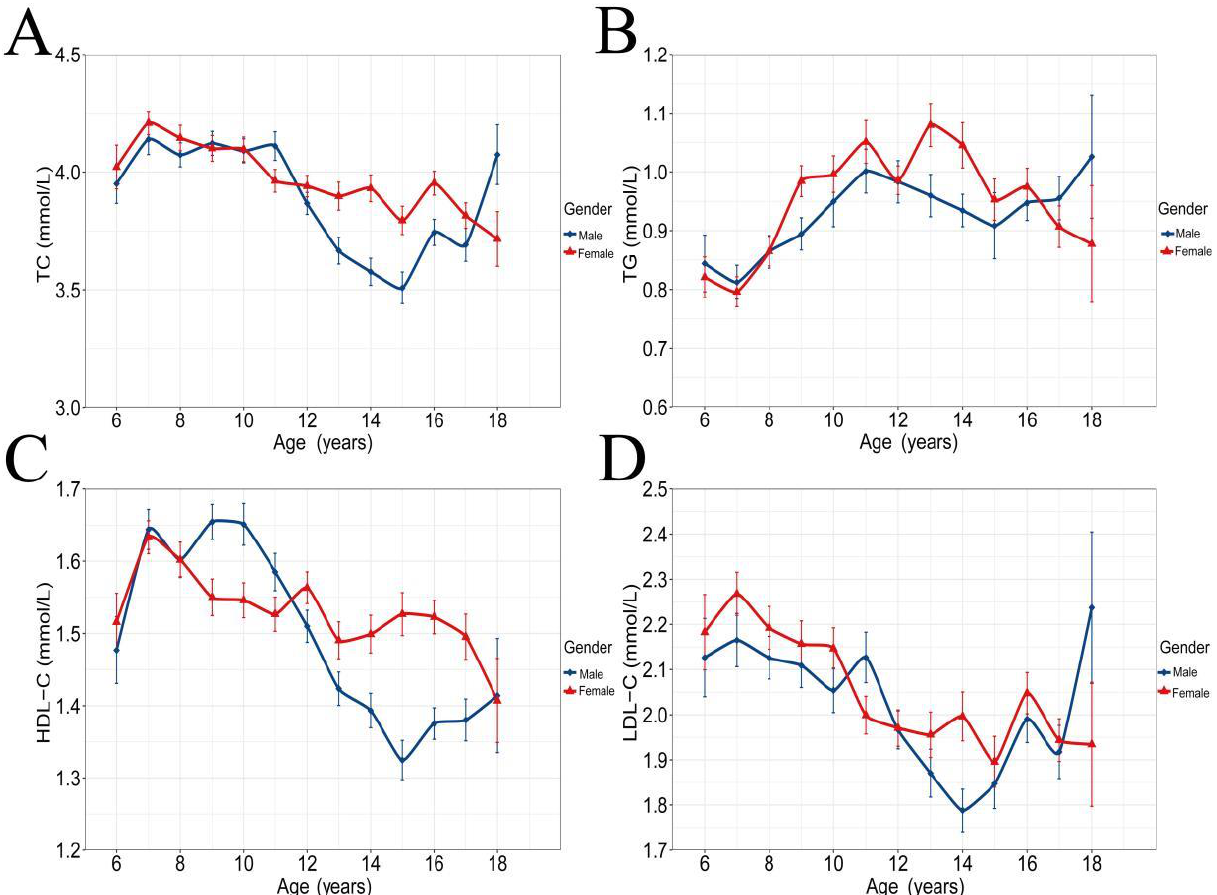
Figure 1. Change in vitamin A with age for different sexes. Means and standard error of the means are shown.